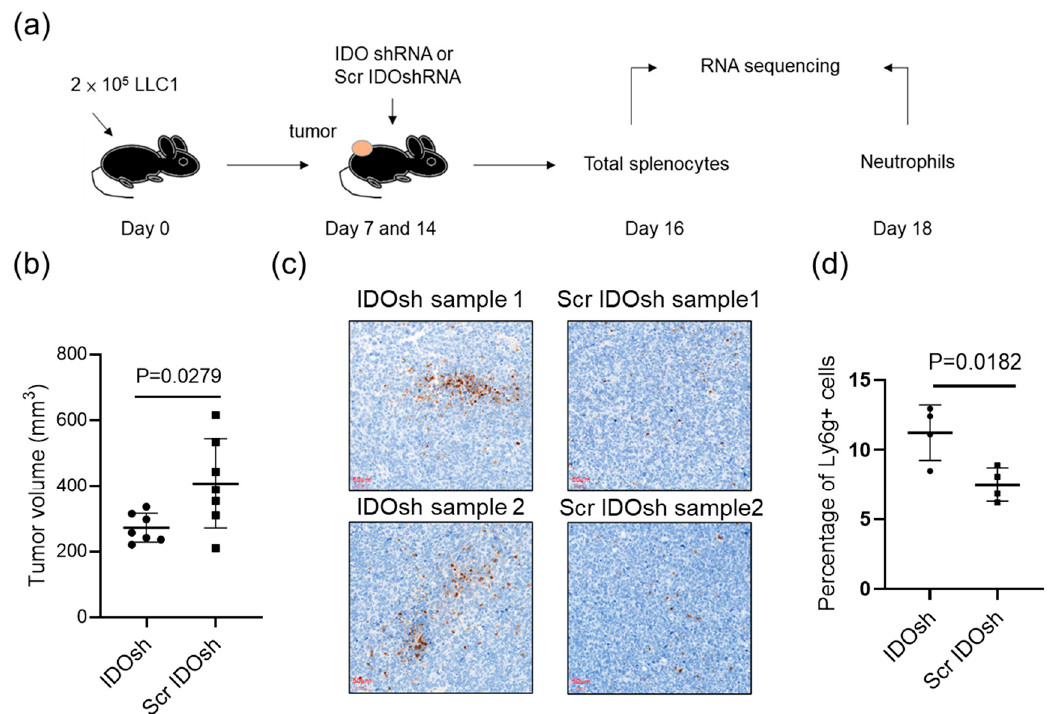
Figure 1. The effect of indoleamine 2,3-dioxygenase (IDO) short-hairpin RNA (shRNA) treatment on LLC1 tumor-bearing mice. ( a ) 2 × 10 5 LLC1 cells were subcutaneously injected into female inbred C57BL/6JNarl mice. Then, 50 μ g of Scramble IDO shRNA (Scr IDOsh) or IDO shRNA (IDO sh) was treated by intramuscular injection at 7 and 14 days after LLC1 injection. The total splenocytes at day 16 and magnetic bead-enriched neutrophils at day 18 were collected, and subsequently subjected to RNA sequencing. ( b ) Mean tumor volume at day 16 ( n = 7). ( c ) The tumor-infiltrating Ly6g + cells. The labels sample 1 and sample 2 indicate that the images were taken from two independent murine tumors of each group. ( d ) Quantification of Ly6g + cells for immunohistochemistry analysis ( n = 4). 2.2. The Expression Pattens of Inflammatory Molecules in Total Splencytes and Splenic Neutrophils